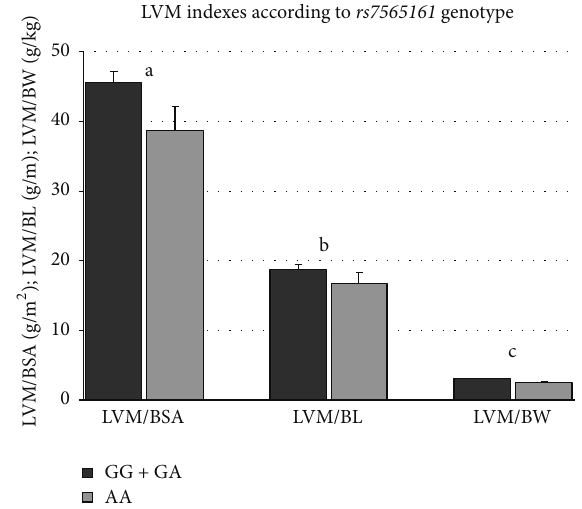
Figure 2: LVM indexes according to rs7565161 genotype. Mean and SEM are shown. a 𝑃 = 0.075 ; b 𝑃 = 0.172 ; c 𝑃 = 0.036 ; a , b , c GG + GA versus AA.